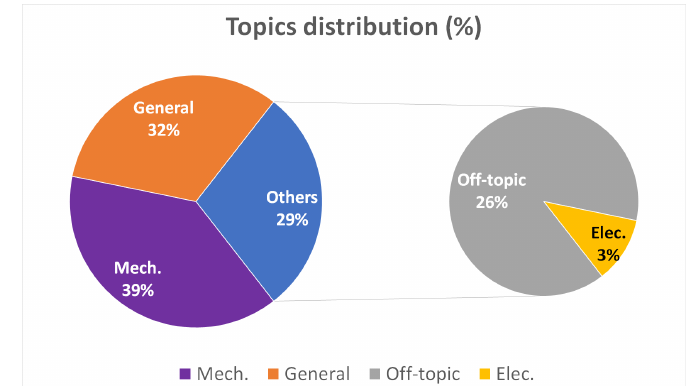
Figure 4. Paper distribution per